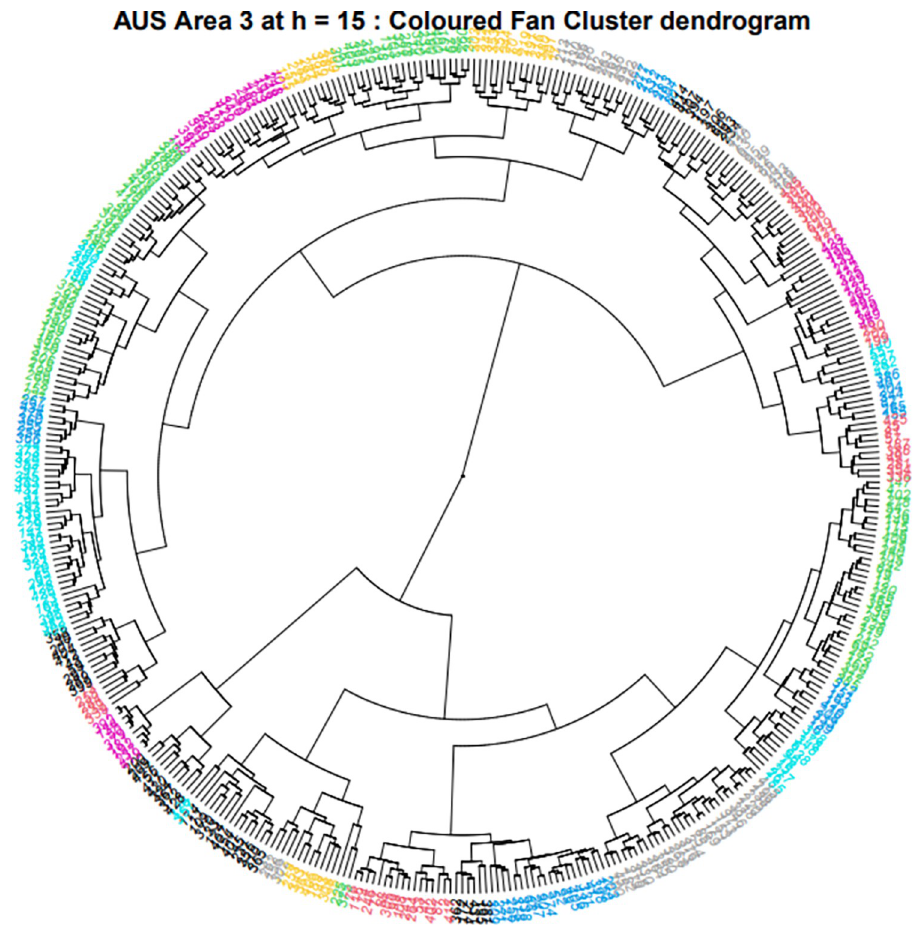
Fig 3. Fan dendrogram of cluster results for Australia Dataset Area 3. Each cluster is represented by a colour.